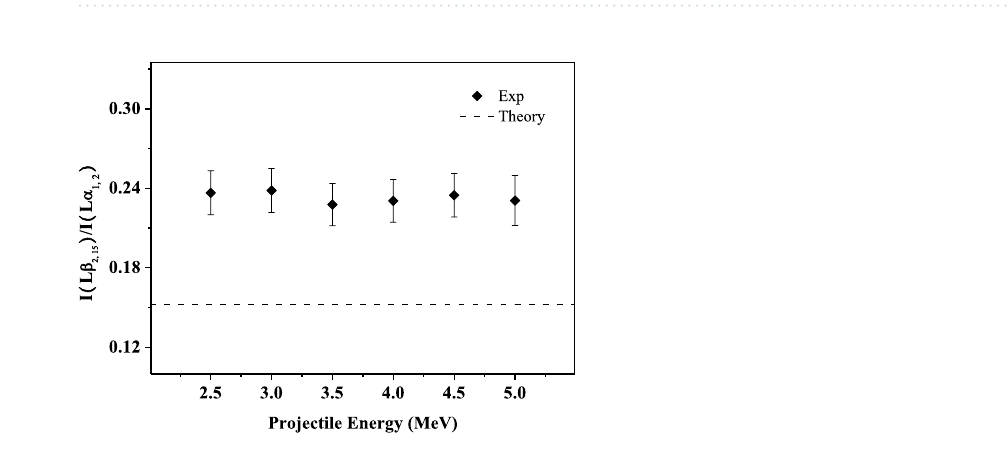
Figure 3. Relative intensity ratios of I Lβ 1, 3, 4 to Lα 1, 2 X-ray as a function of incident energy.